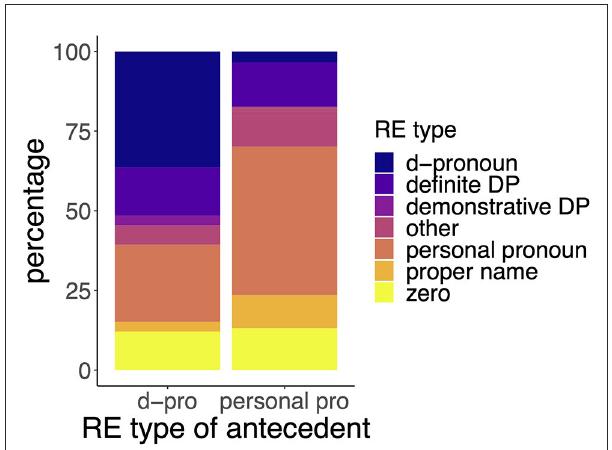
FIGURE1 Distribution of type of referring expression of the critical pronoun’s antecedent. Distribution of d-pronoun’s antecedent on the (Left) , distribution of personal pronoun’s antecedent on the (Right)